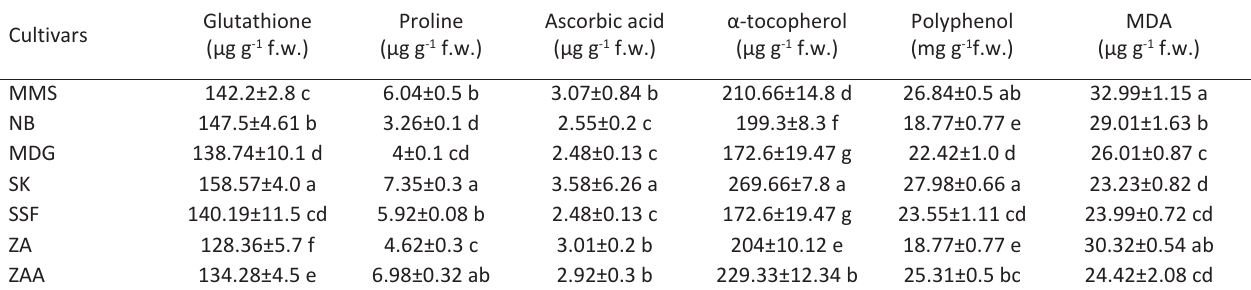
followed by the same letters within columns are not different at 5% probability using Duncan’s test. All data indicated mean ± standard error (n =